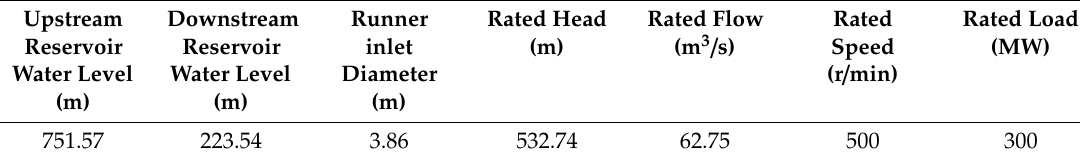
Table 1. PSP parameters.